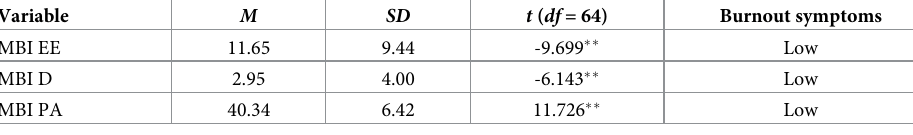
Table 2. Results of burnout symptoms in the sample of palliative home care practitioners.